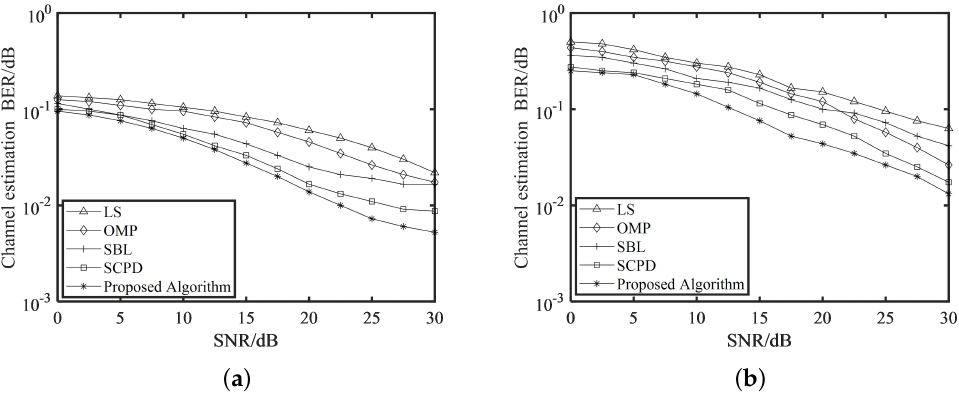
Figure 6. BER performance versus SNR for channel estimation. Simulation setup: single vehicle; the number of transmit antennas N R = 16, and the transmit RF chains M R = 16; the number of receive antennas N V = 4, and the receive RF chains M V = 4. ( a ) The vehicle speed is 90 km/h. ( b ) The vehicle speed is 150